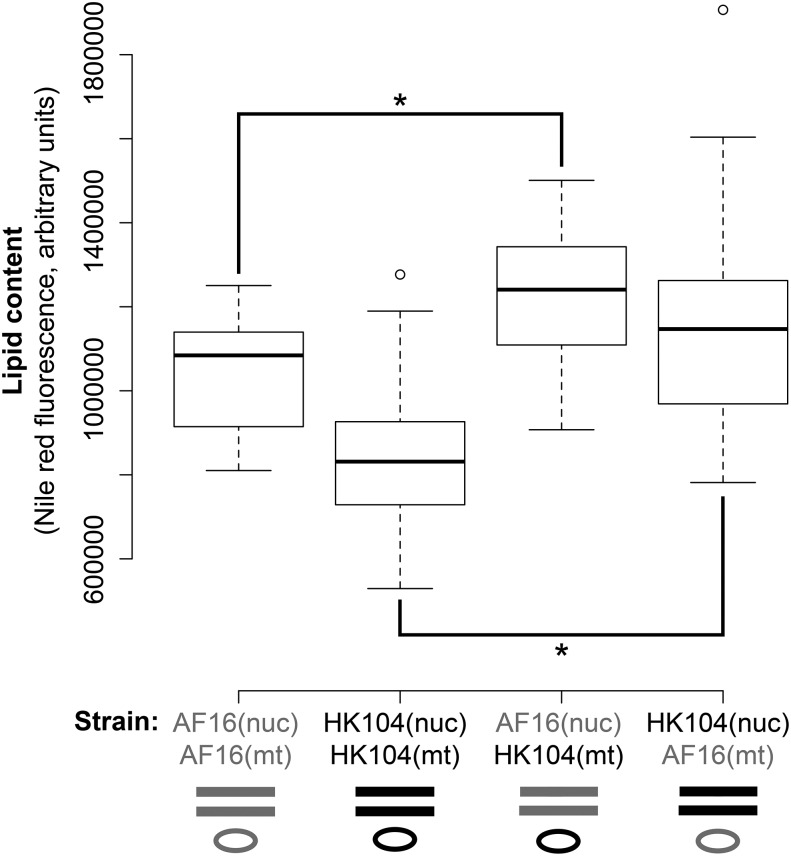
Comparison of parental and cybrid lipid content. Boxplot of whole-animal lipid content measured by Nile red fluorescence. Comparisons between replicate cybrids and the paternal parental strain revealed significant increases in lipid content in cybrids (*P < 0.05; Bonferroni-corrected unpaired two-tailed t-test).